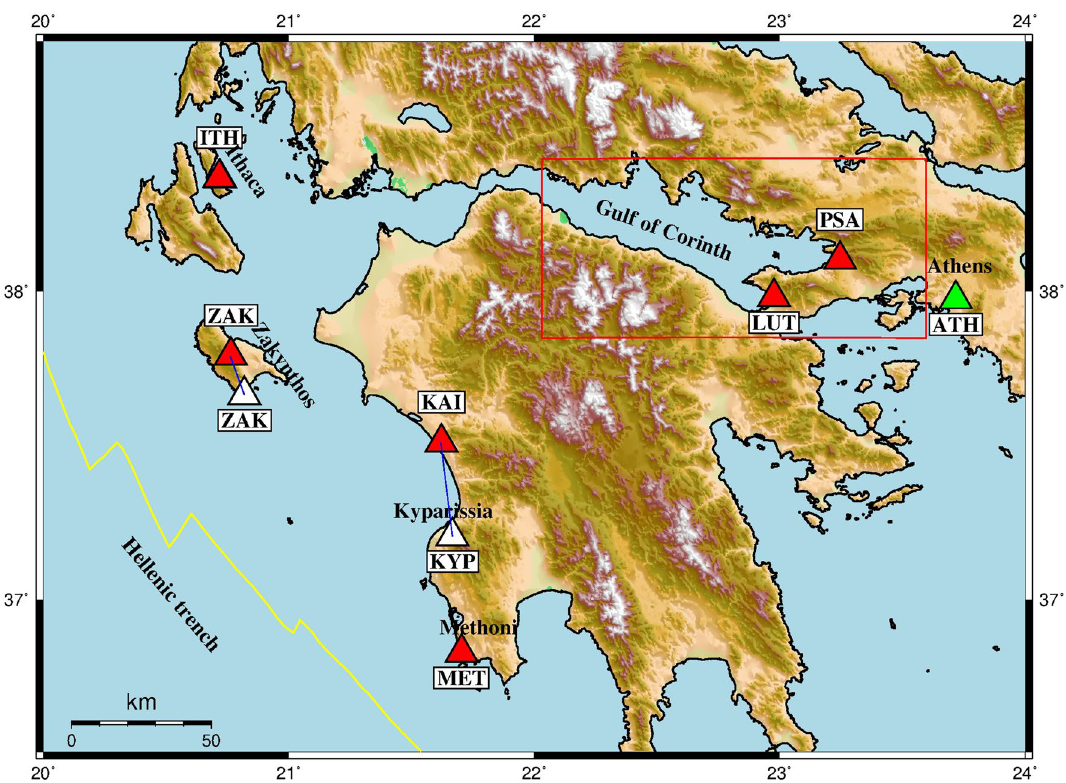
Figure 1. The gamma-ray station locations of the real-time network of NOA for soil radon concentration measurements (red triangles). Older station locations are also shown (white triangles). The alpha-particle station for Rn monitoring in the air is shown with green triangle. The region in the red rectangle includes the investigation area. The figure has been created by the “Generic Mapping Tools” GMT5.0 software (https:// www. gener ic- mappi ng- tools.